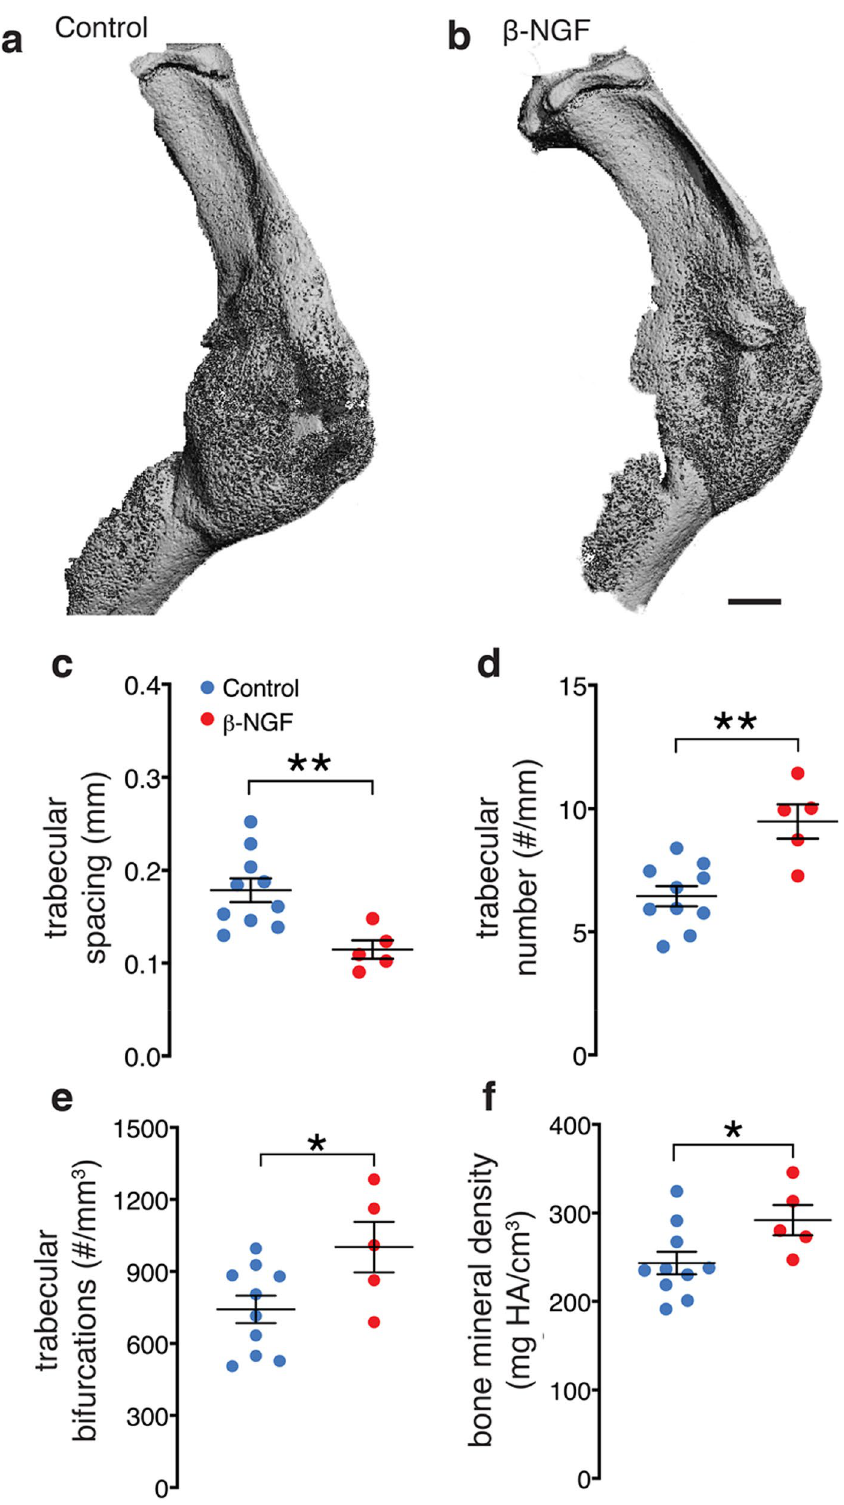
Figure 6. Local injections of β-NGF results in highly connected trabecular bone. μCT images of tibias from ( a ) control and ( b ) β-NGF treated mice, 14 days post fracture. Scale bar = 1 mm. Quantification of ( c ) trabecular spacing ( d ) trabecular number ( e ) trabecular connective density and ( f ) bone mineral density. Error bars represent SEM. *p < 0.05; **p < 0.01 determined by 2-tailed t